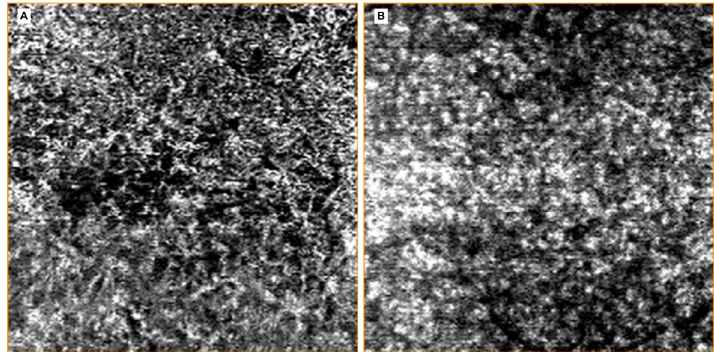
Figure 8. OCTA analysis of the choriocapillary vascular structure in a patient affected by radiation chorioretinopathy in his left eye ( A ). Choroidal vessels are rarefied and dilatated; “signal void” spots are recorded in the central area. The normal appearance of the choriocapillary vascular structure of the fellow-eye is showed in ( B ).